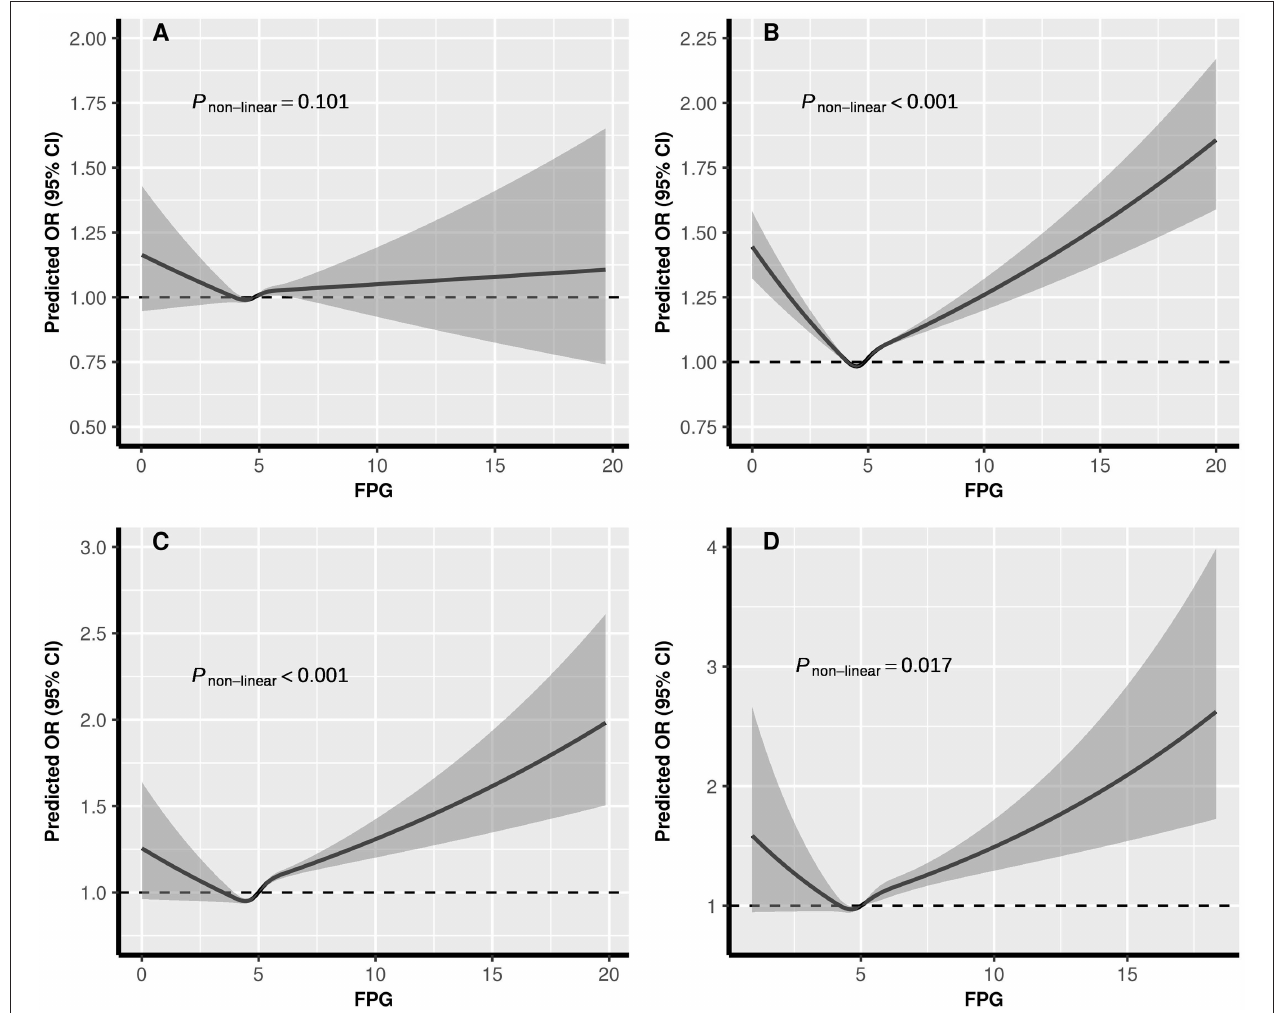
FIGURE 3 | The exposure-response relationship of pre-conception FPG with PTB, stratified by BMI. BMI, body mass index; FPG, fasting plasma glucose; PTB, (pre-term birth, 28 to < 37 weeks). (A) Underweight; (B) Normal weight; (C) Overweight; (D) Obesity. In the graph, black lines and shaded gray areas represent predicted ORs and 95% CIs, respectively. The models were adjusted for characteristics of women (age, education, ethnic, occupation), parity, smoking and alcohol drinking before or during early pregnancy, history of adverse pregnancy outcomes, history of hypertension, thyroid dysfunction, anemia, infectious disease, and sex of